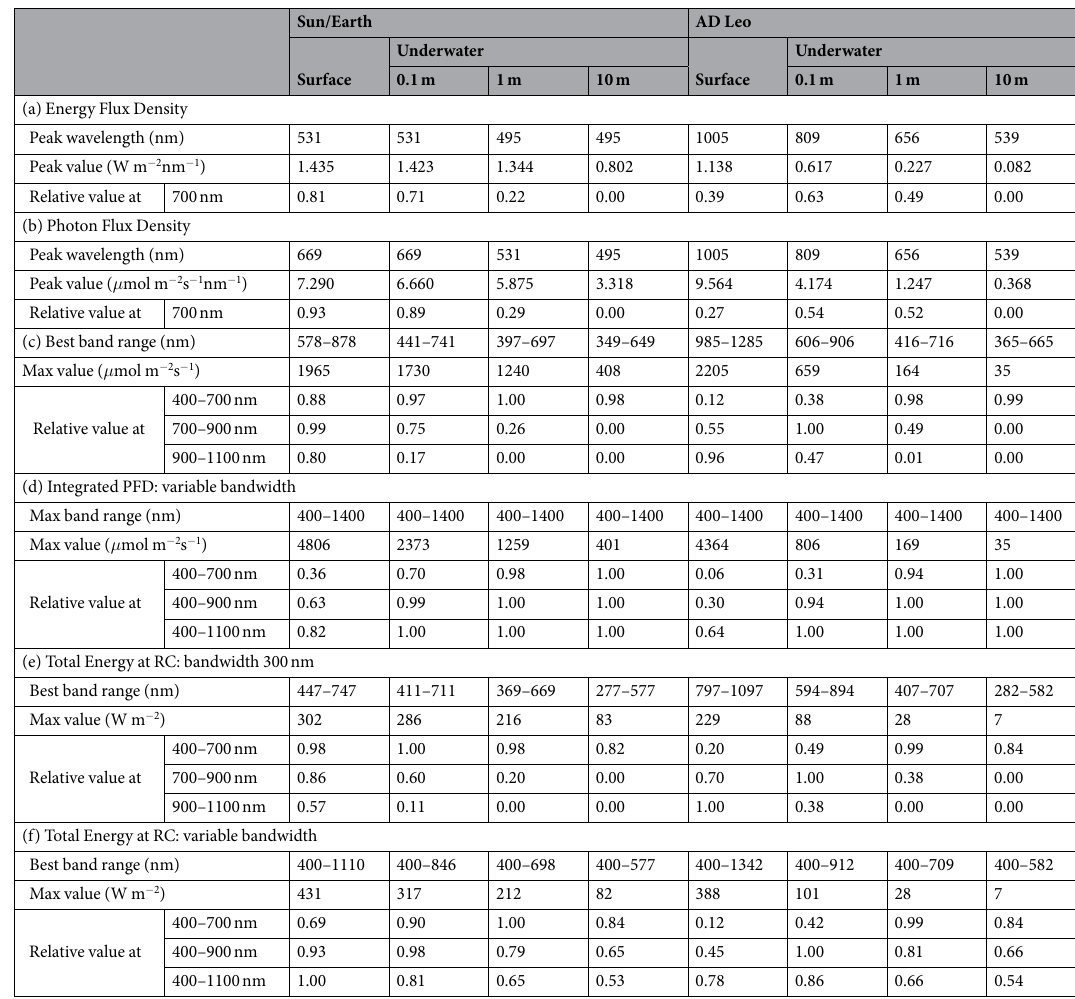
Table 1. Lighting conditions on the Earth and a habitable planet around AD Leo. Parameters for EFD (a) and PFD (b) were obtained from spectra shown in Supplementary Fig. 1. Integrated PFDs were calculated for a fixed bandwidth at 300 nm (c) or a variable bandwidth (d). Integrated PFDs increased as bandwidth increased and were not saturated. Total energies obtained at the reaction centers (RCs) were calculated from the integrated PFDs and the RC wavelength, as shown in sections e and